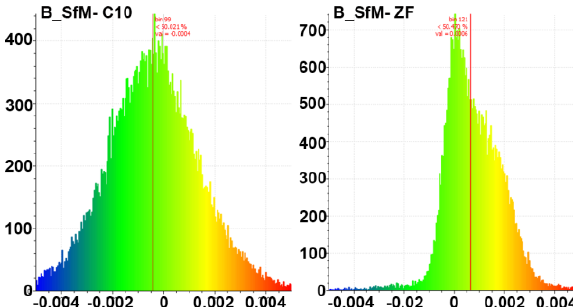
Figure 11 . B. Histograms of the comparison between SfM and C10 (left) and SfM and ZF